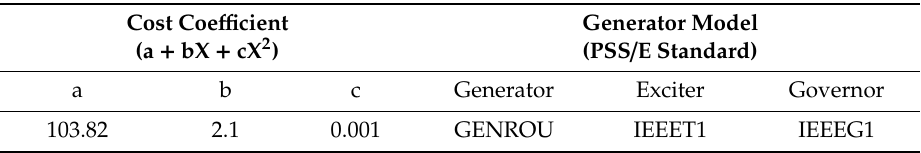
Table 3. Cost coe ffi cient and model of